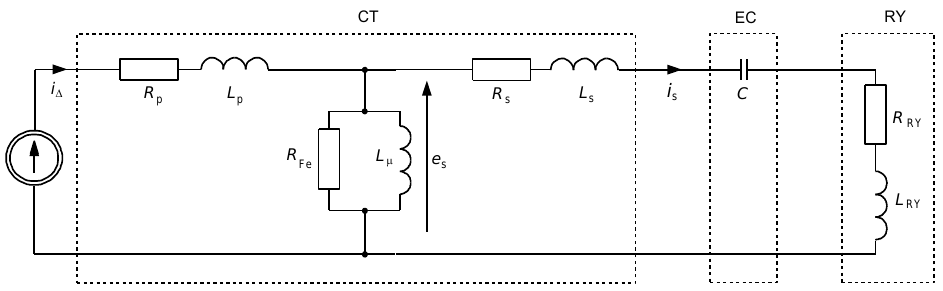
Figure 2. Equivalent circuit of the RCD: e s —induced secondary voltage; i Δ —residual (primary) current; i s —secondary current; C —matching capacitor; R Fe —resistance representing excitation losses; L μ —inductance with magnetic hysteresis; R p , L p ,—parameters (resistance and inductance) of the CT primary winding; R s , L s —parameters (resistance and inductance) of the CT secondary winding; R RY , L RY —parameters (resistance and inductance) of the relay.